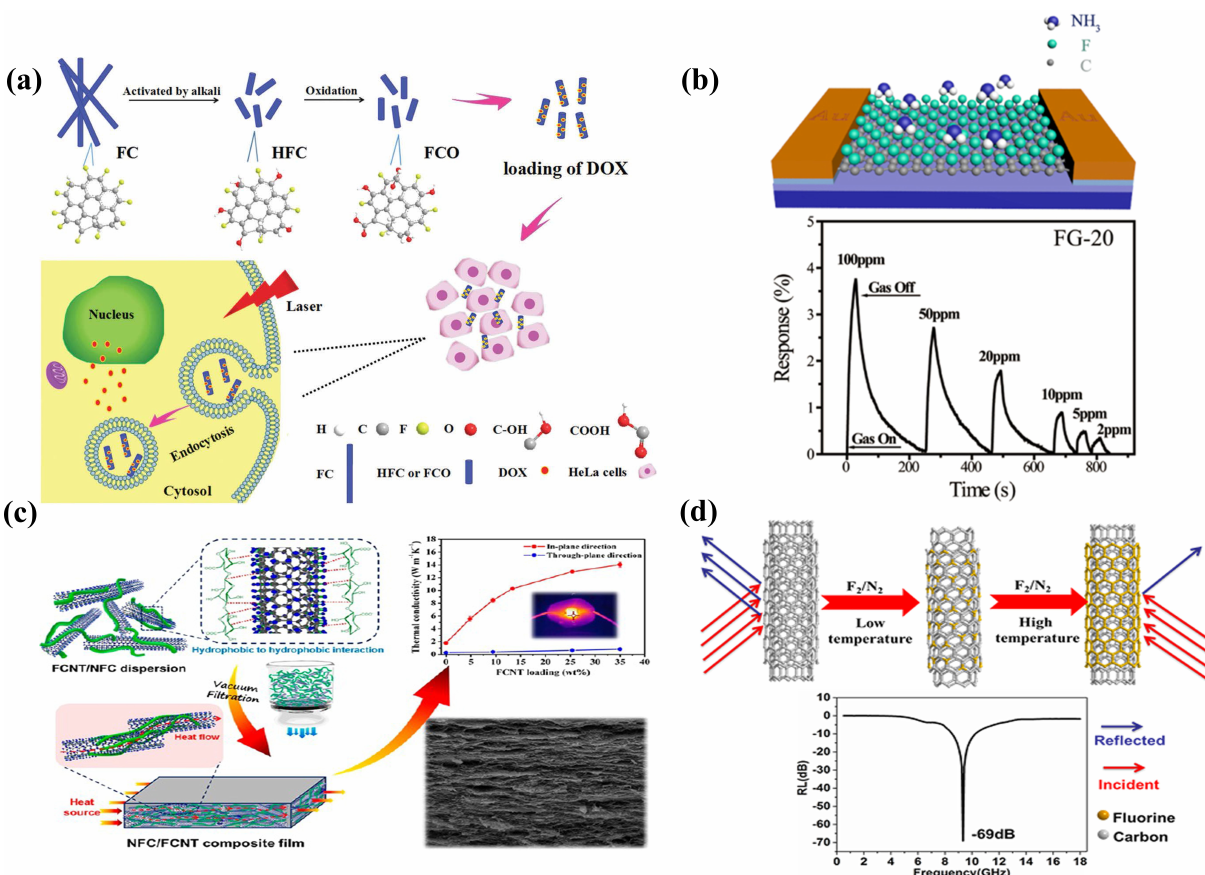
Figure 5: (a) Preparation and application of fluorinated carbon fiber oxide (FCO) as a novel nanocarrier. Illustration of synthesis of FCO by activation and oxidation and loading of DOX and intracellular release combined with photothermal therapy of cancer cells. Reprinted with permission from [104]; schematic illustration of (b) the FG-based gas sensor. Reprinted with permission from [107]; (c) the preparation of the NFC/FCNT composite films. Reprinted with permission from [43]; (d) the preparation of F-h-MWCNTs through direct heating